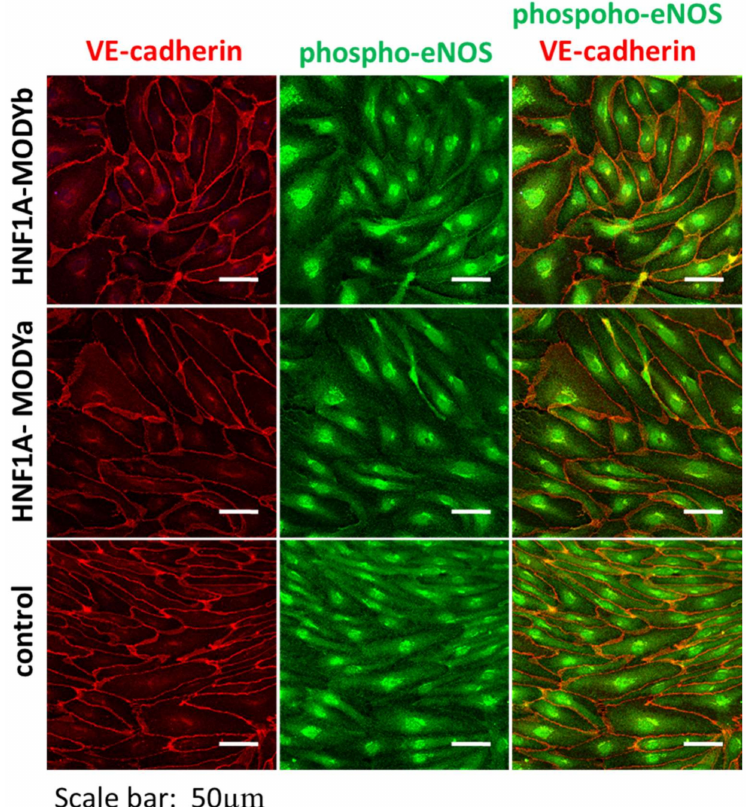
Figure 6. hiPSC-derived endothelial cells differentiated as described in [63]. Cells were derived from healthy (control) and two HNF1A-MODY individuals (HNF1A-MODYa and HNF1A-MODYb). No difference in the expression of VE-cadherin (red) or phosphorylated form of endothelial nitric oxide synthase (phospho-eNOS, green) could be